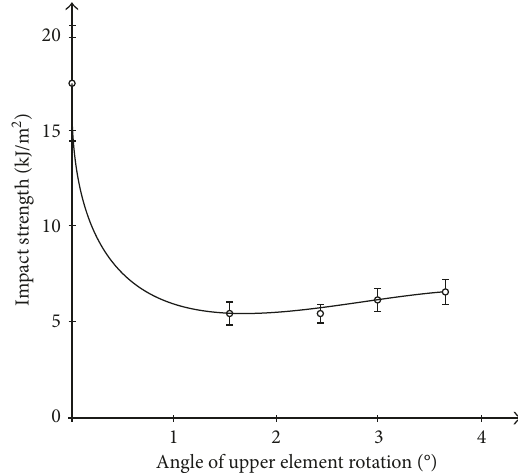
Figure 5: Impact strength of joints with a rotated spacer.